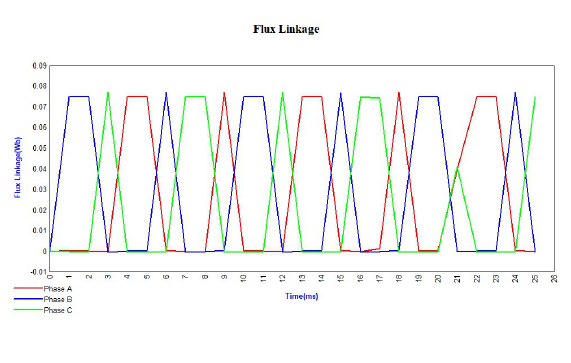
Fig. 9. 10/6 SRM Phase Current.